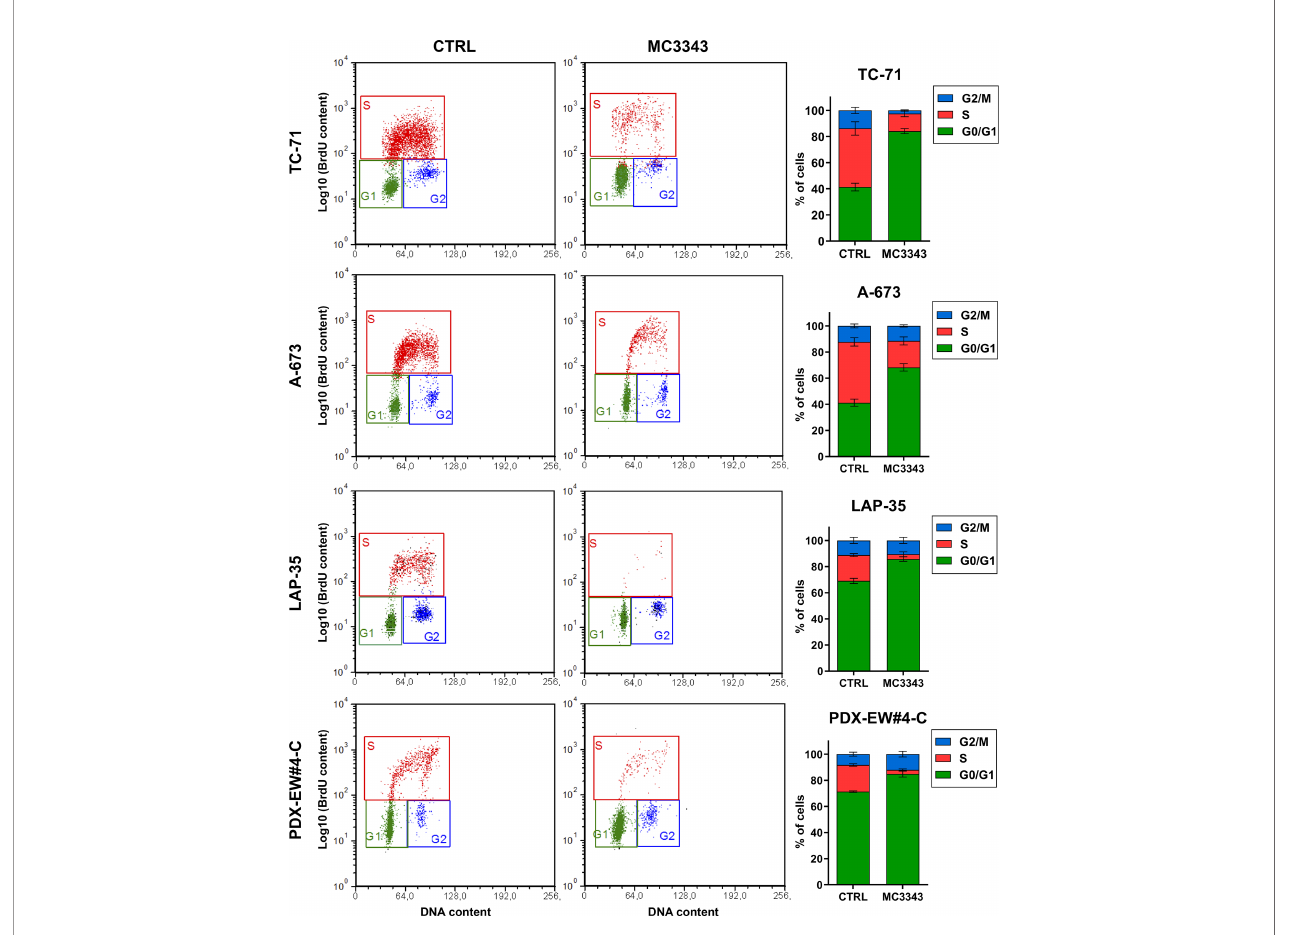
FIGURE 2 | MC3343 induces a G1 block in EWS cells. Cell-cycle analysis of four representative EWS cell lines after 24 h of exposure to MC3343 as determined by BrdU uptake. x-axis indicates DNA content (PI) and y-axis indicates BrdU incorporation (log 10 ). In each panel, the different stages of the cell cycle are highlighted. Percentages of cells in each cell-cycle stage are shown in histograms on the right. Data represent the mean ± SE of at least three